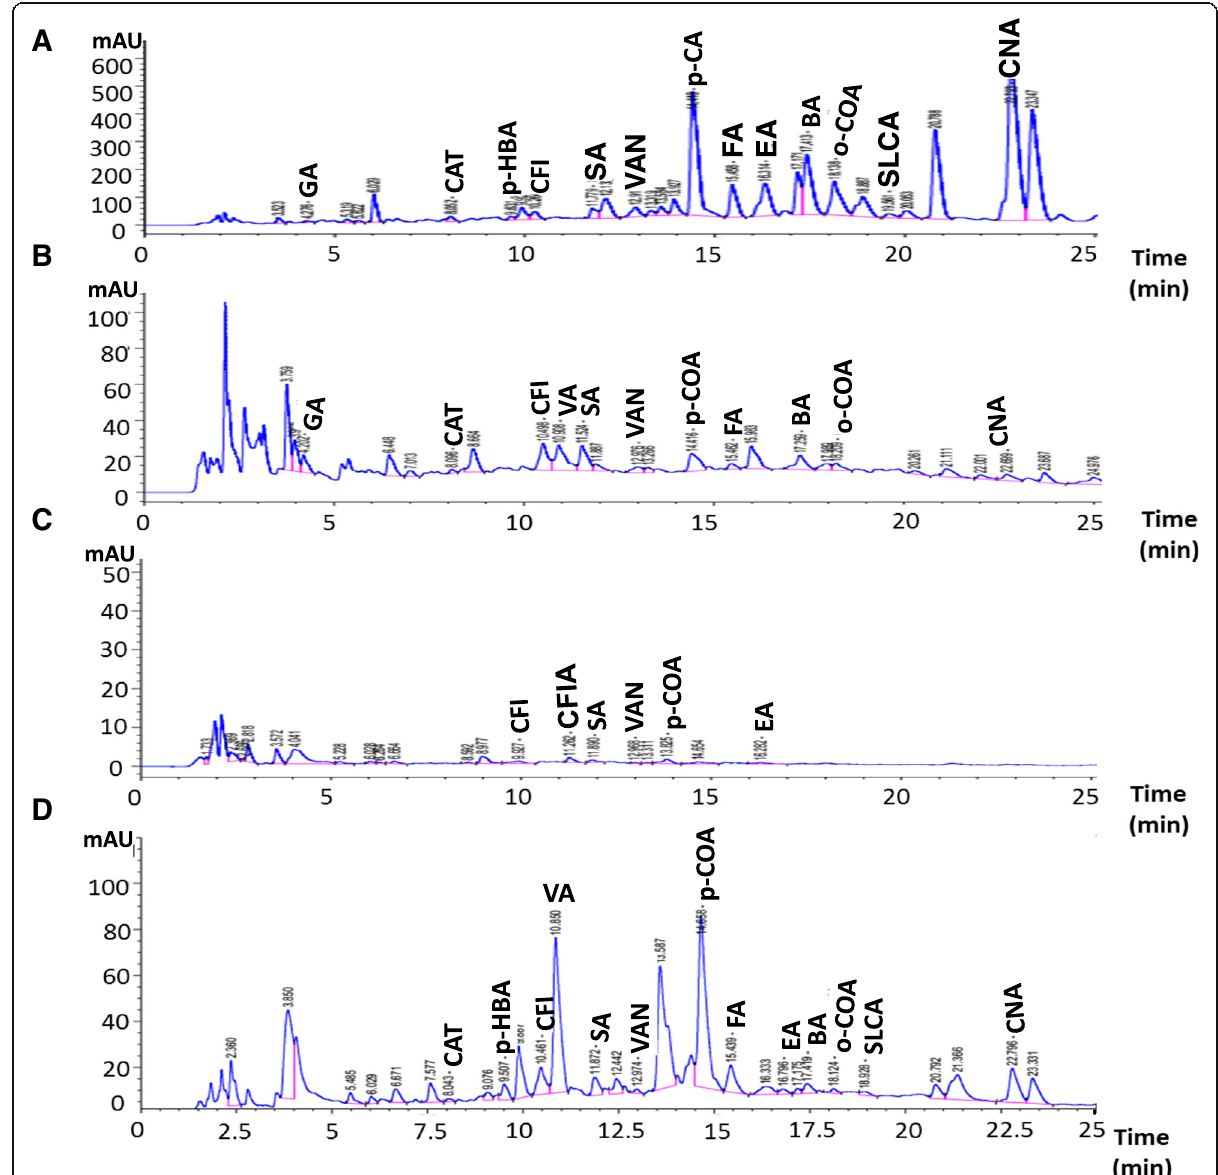
Fig. 1 HPLC chromatograms of the phenolic compounds in ( a ) Ammi visnaga extract (AVE ) ( b ) Petroselinum crispum extract (PCE) ( c ) Hordeum vulgare extract (HVE) and ( d ) Cymbopogon schoenanthus extract (CSE). CAN; Cinnamic acid, CAT; catechol, CFI ; caffeine , CFIA; Caffeic acid, COA ; coumaric acid, EA; Ellagic acid, FA; Ferulic acid, GA; gallic acid, p-HBA ; p-hydroxybenzoic acid, SA, Syringic acid, SLCA; Salicylic acid, VA ; vanillic acid, VAN;